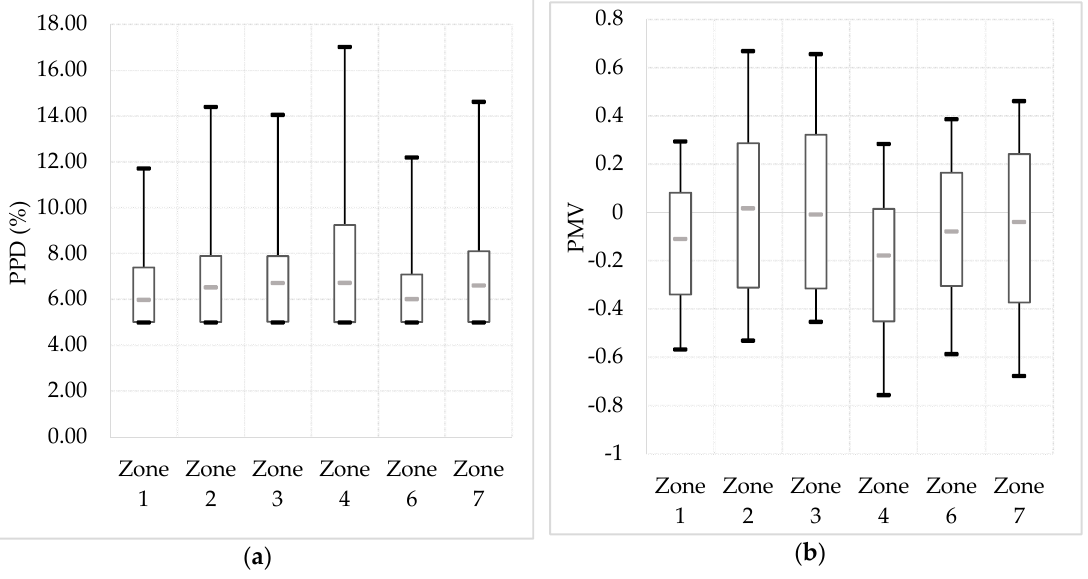
Table 8. Considered parameters to calculate the indicators. Parameters